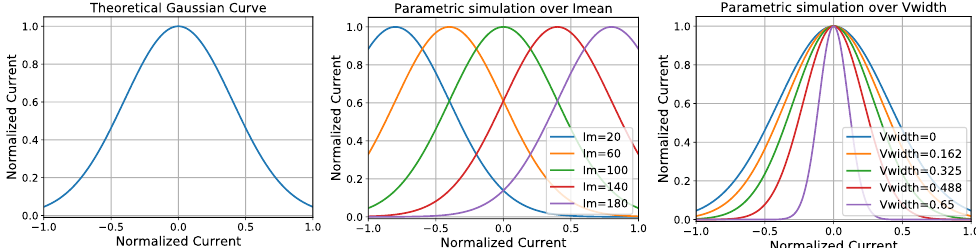
Figure 12. Theoretical output current of an example of a circuit based on the Translinear Principle ( left ) Simulation for I m = 100 and V width = 0.4 ( center ) Parametric simulation over I m for V width = 0.4 ( right ) Parametric simulation over V width for I m =